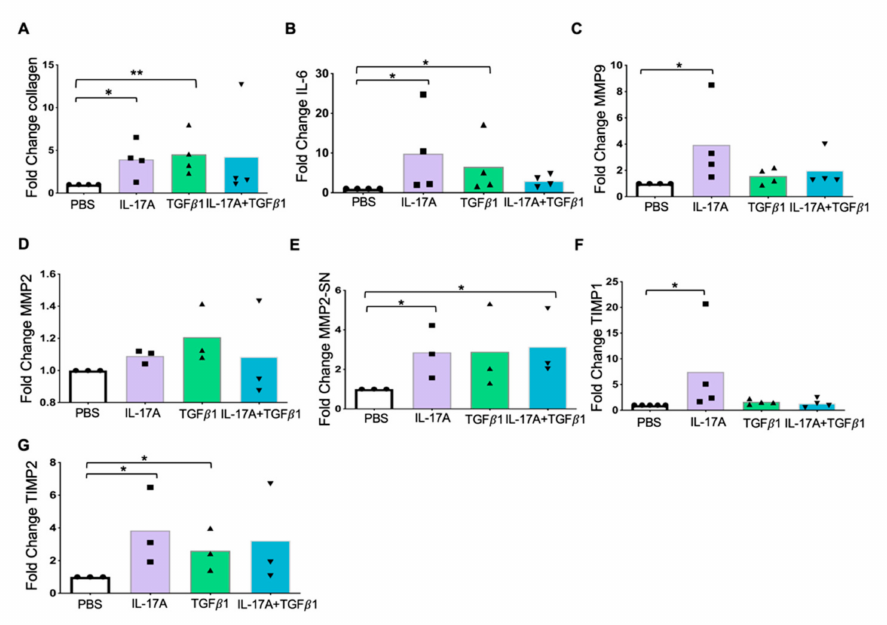
Figure 6. Changes in fibrotic markers’ expression under IL-17A (30 ng/mL) and TGF- β 1 (2.5 ng/mL) of F0–F1 human liver slice culture for 50 h (ELISA). The results are presented as fold change- treated/PBS. ( A ) Fold change for collagen expression in liver tissue lysates. ( B ) Fold change for IL-6 expression in liver tissue lysates. ( C ) Fold change for MMP-9 expression in liver tissue lysates. ( D ) Fold change for MMP-2 expression in liver tissue lysates. ( E ) Fold change for activated MMP-2 secretion in the supernatant. ( F ) Fold change for TIMP-1 expression in liver tissue lysates. ( G ) Fold change for TIMP-2 expression in liver tissue lysates. The statistical test for ELISA: one-sample two-tailed t-test for F = log 2 (fold change), * p < 0.05, ** p <